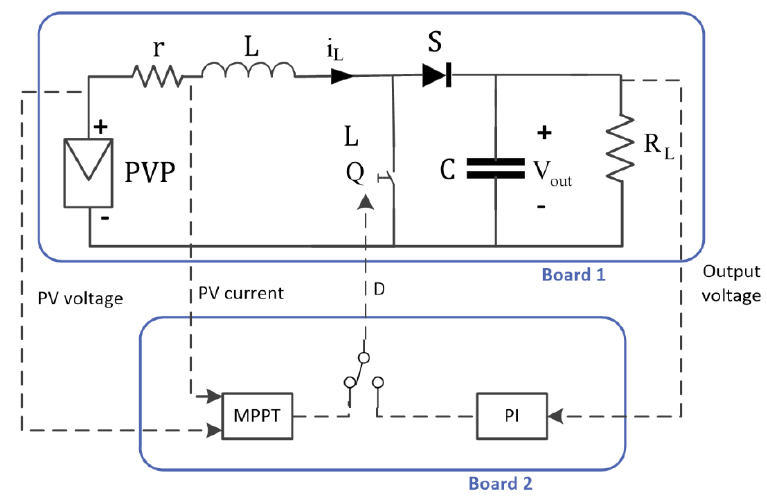
Figure 17. Connection between development boards.